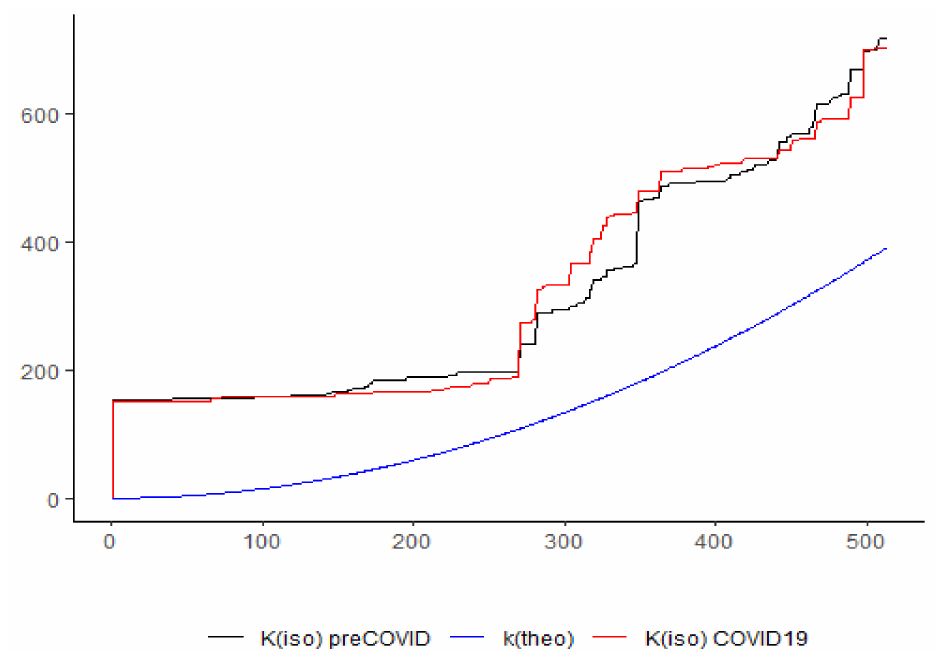
Figure 2. Ripley’s K function, isotropic. Source: Authors’ own with R